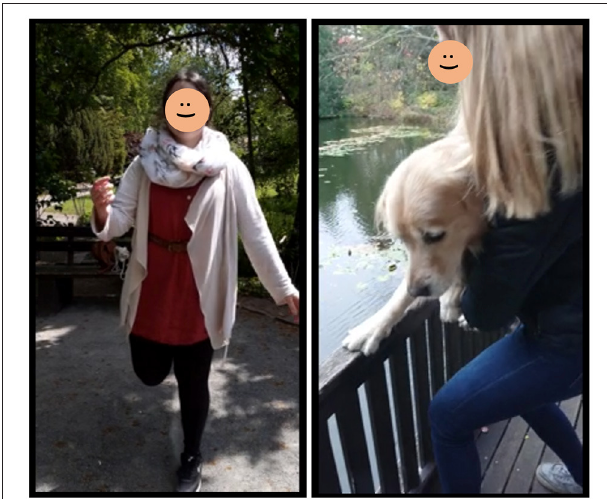
FIGURE 4 | Screenshot of video answers. Both screenshots are part of video answers from students. They answered the question “Proprioception means the ability to sense the position of the body and the limbs. Record a short video (10–20s) where you show how proprioception can be tested.” The first picture shows a student while balancing on one leg. The second picture displays a student performing the placing reaction with her own